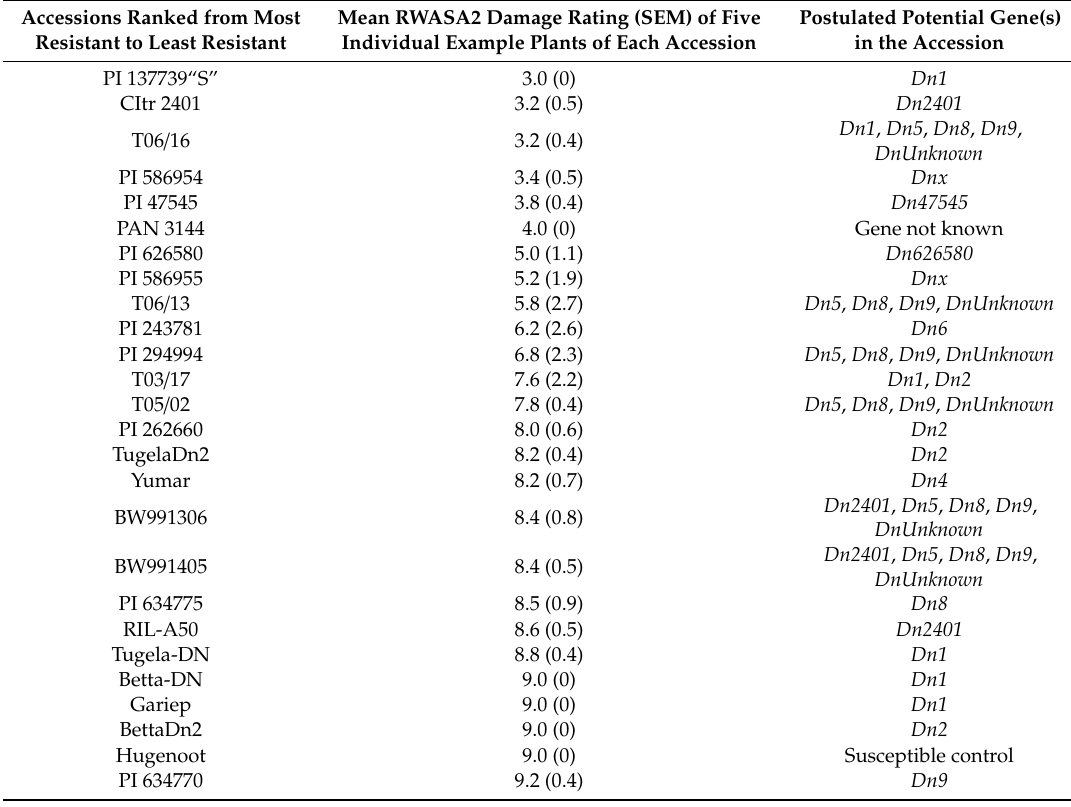
Table 2. Rank of test entries using the t -distribution test ( p = 0.05) of the mean damage rating (SEM) of each accession to biotype